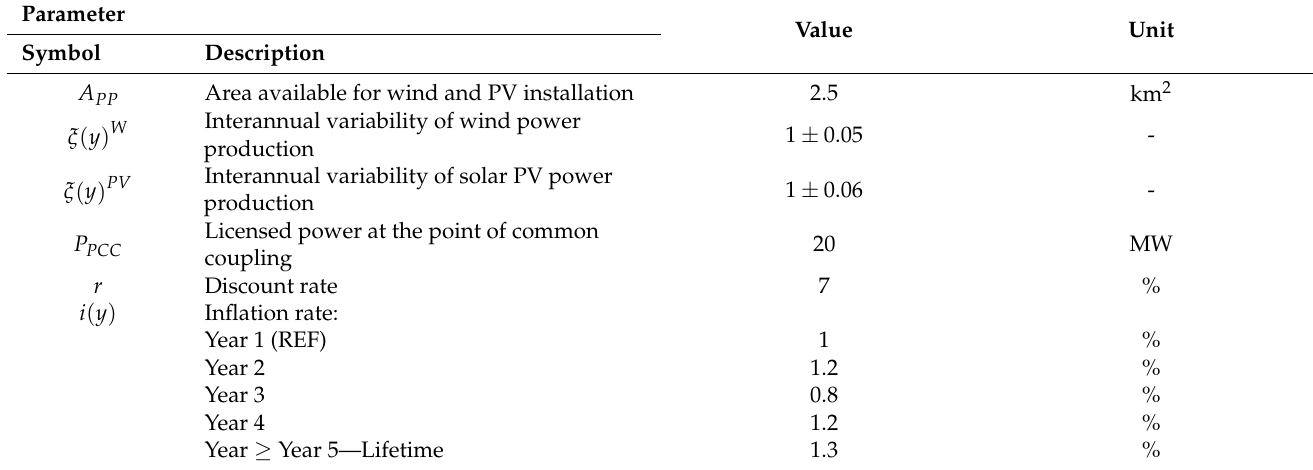
Table 2. Technical and economic data used in the study.